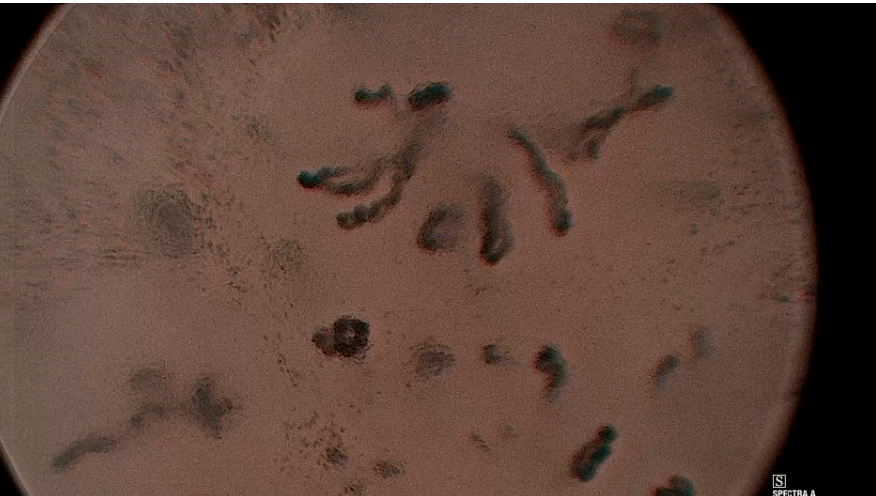
Figure 5. Histologically verified supraglottic squamous cell carcinoma. Puxxedu classification type IV.